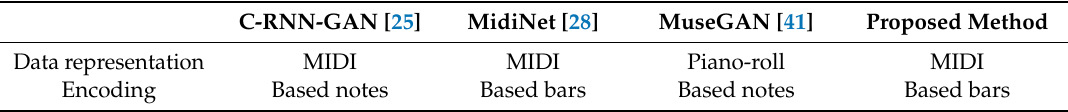
Table 1. Di ff erences between traditional music generation systems and the proposed